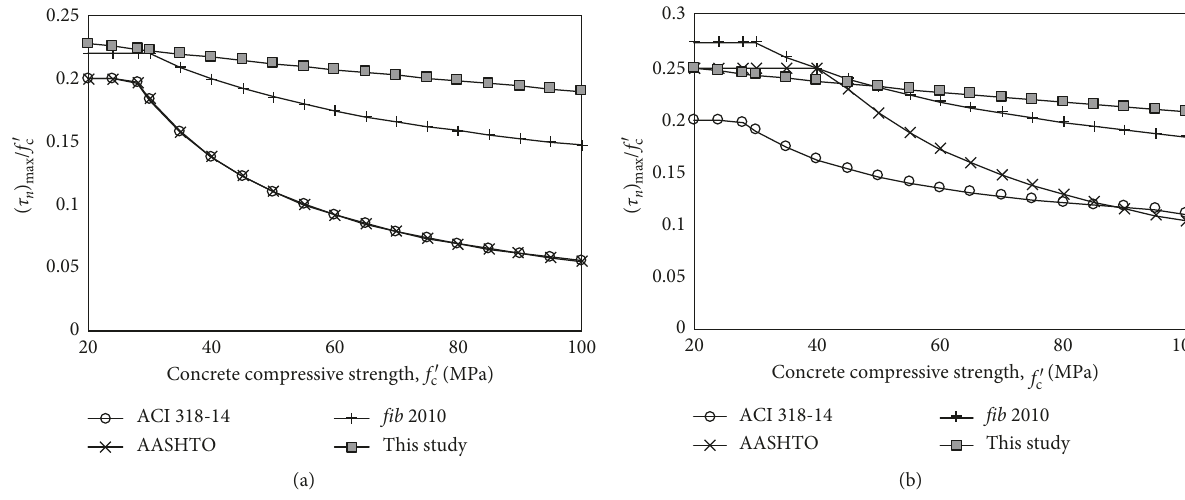
Figure 6: Comparisons of